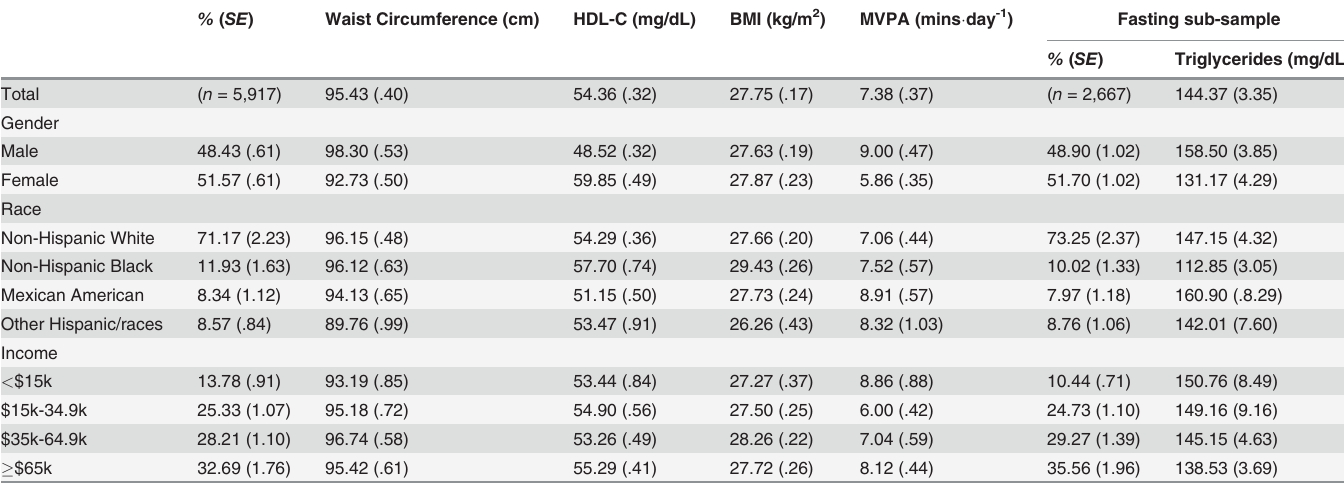
Table 1. Descriptive Statistics of Outcome Variables across Demographic Characteristics among US